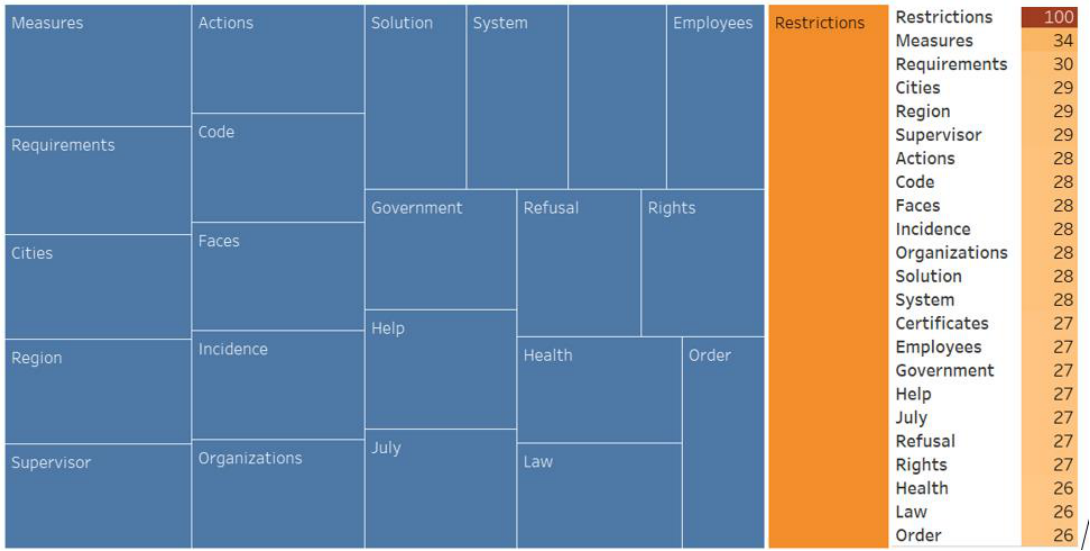
Figure 10. Associative network of the “Quarantine restrictions” stimulus in the negative cluster.